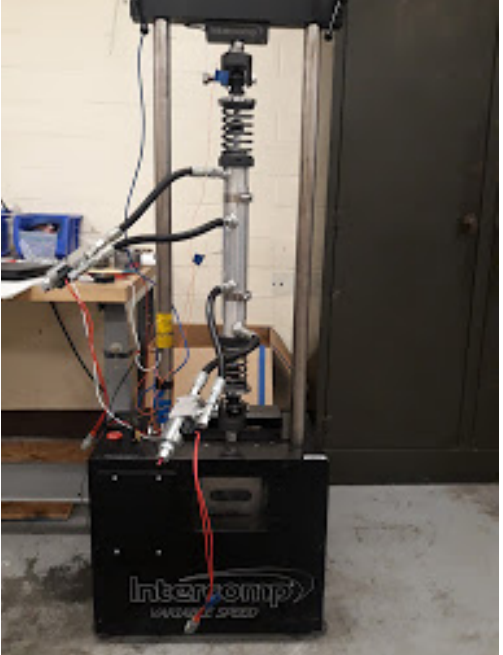
Figure 3. Double Damper with springs system mounted on the Shock